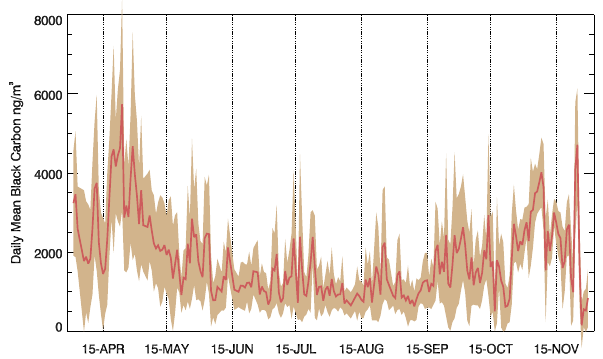
Fig. 2. Daily mean black carbon concentration observed over Gadanki. Gray area indicates the ± 1 σ standard